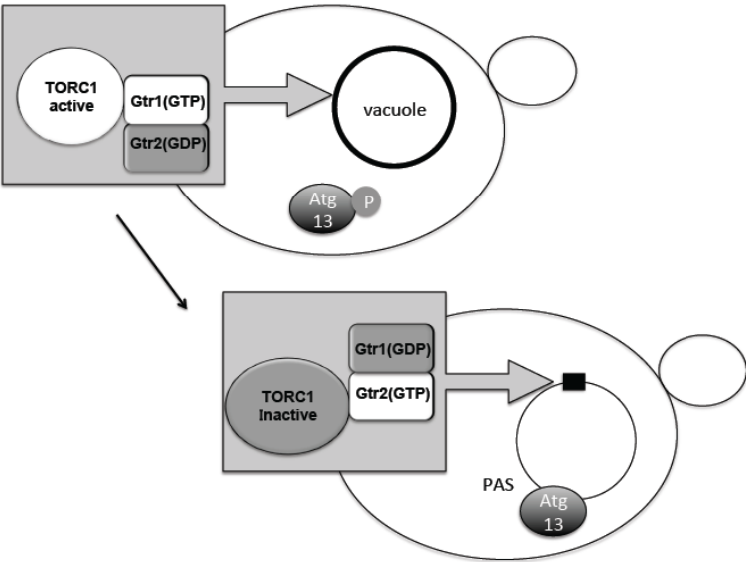
Figure 2. Dynamic relocation of TORC1 is associated with its activity. When Gtr1 takes guanosine 5’ -triphosphate (GTP) form, TORC1 is active and spread over the vacuole. When Gtr2 takes GTP form, TORC1 is inactive and concentrated on a punctuated structure on the vacuole. When TORC1 is active Atg (autophagy related gene) 13 is phosphorylated, and does not gather to preautophagosomal structure (PAS). When TORC1 is inactive, Atg13 is dephosphorylated and gathers to PAS. GDP; guanosine 5’ -diphosphate.